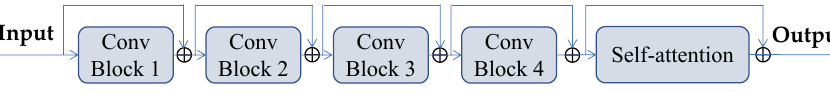
Figure 4. The framework of our feature encoder with